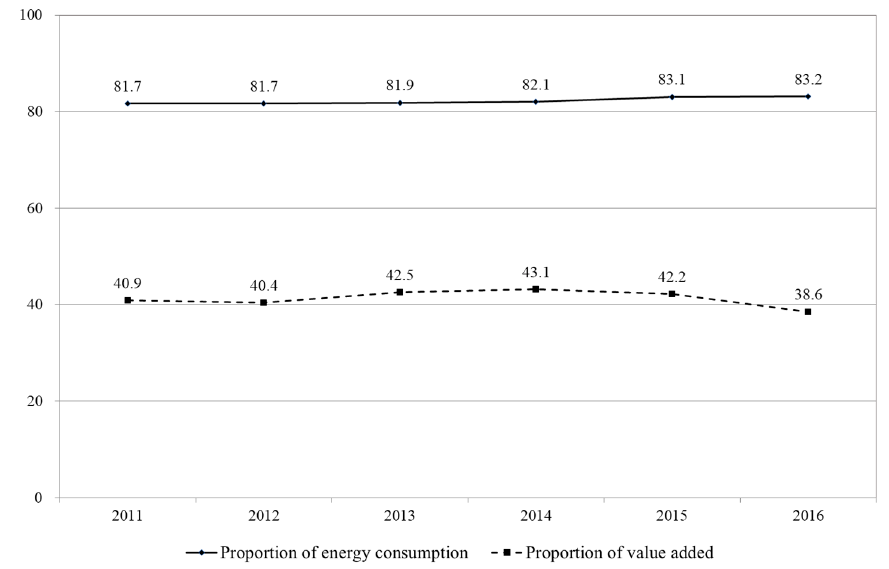
Figure 1. Proportion of energy consumption and added value of high pollution industry in industrial sector (%) [5].